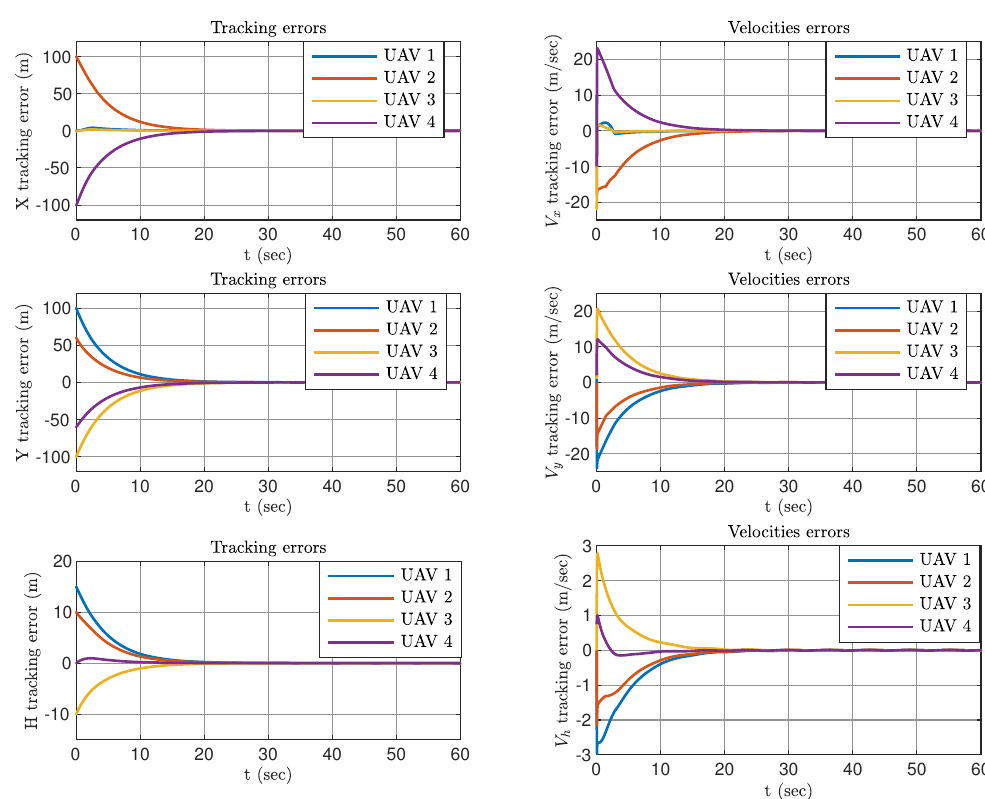
Figure 11. Tracking error comparison curves of three positions and three